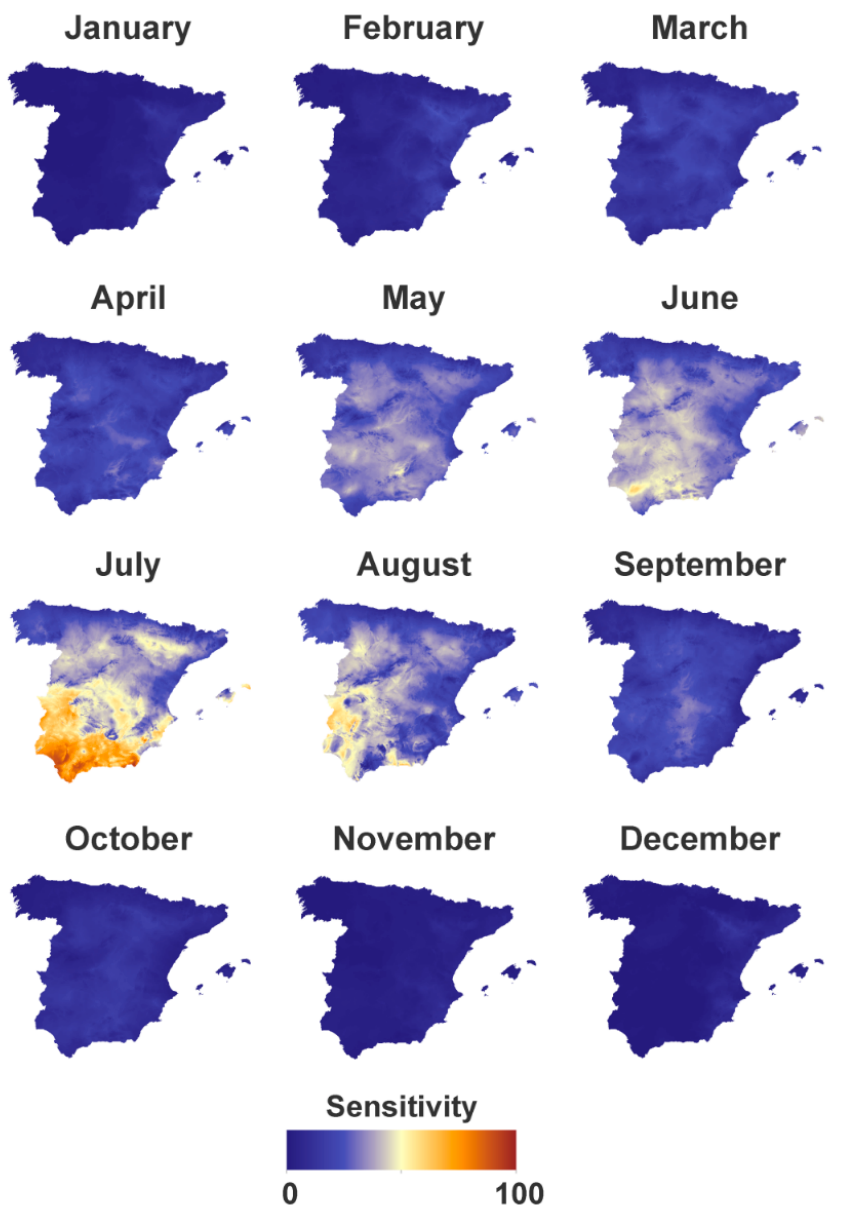
Figure 8. Monthly spatial distribution of the sensitivity (%) of the SPEI to AED on mainland Spain and the Balearic Islands over the period 1961–2018 at a short time scale (1-month). The monthly series include the weekly data for the last week of each month in each year.